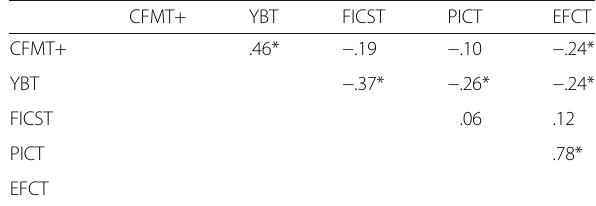
Table 5 Correlation coefficients computed for the CFMT+, YBT, FICST, EFCT and PICT